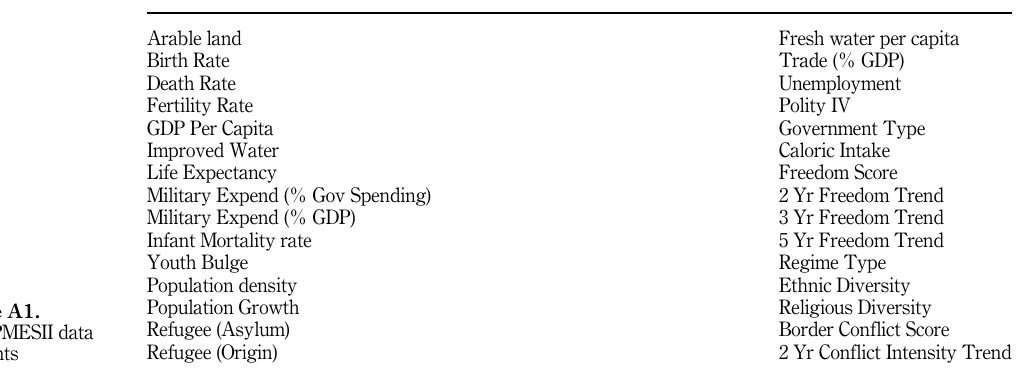
Table A1. PCA PMESII data